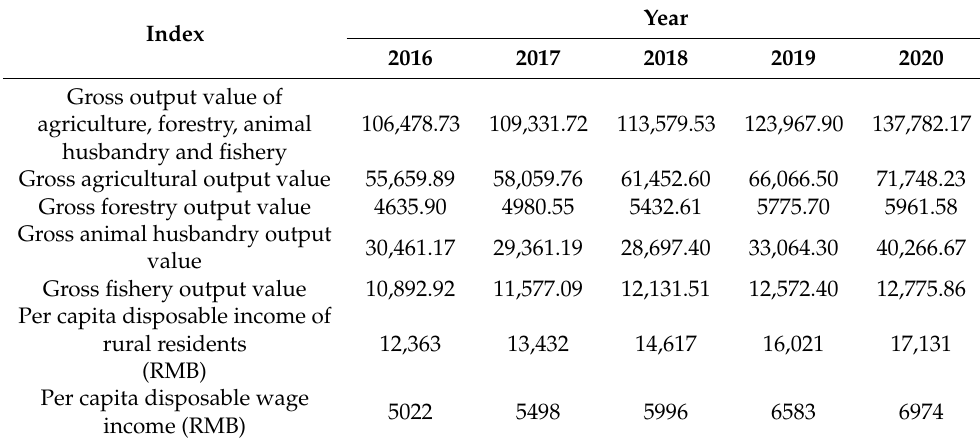
Table 1. Rural economic development (Unit: 100 million